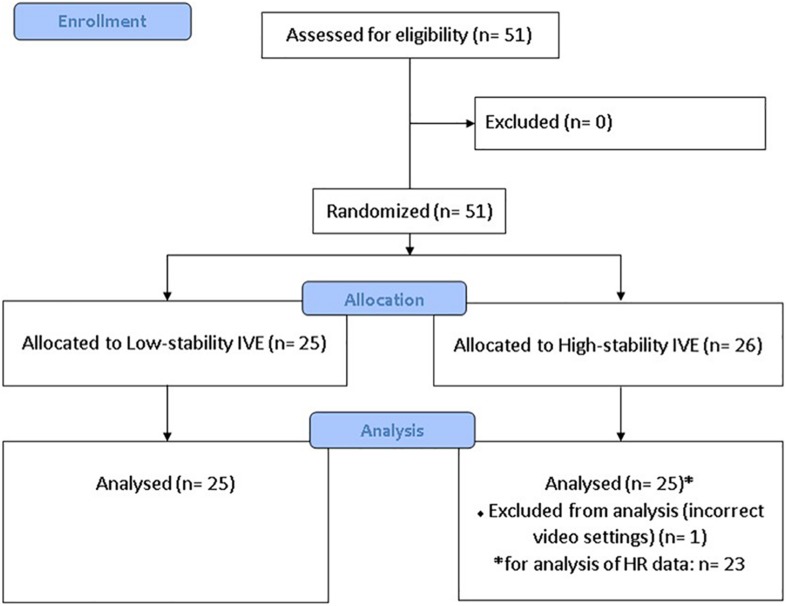
Flow diagram showing participants enrolled, allocated to condition, and included in the analyses (Schulz et al., 2010).